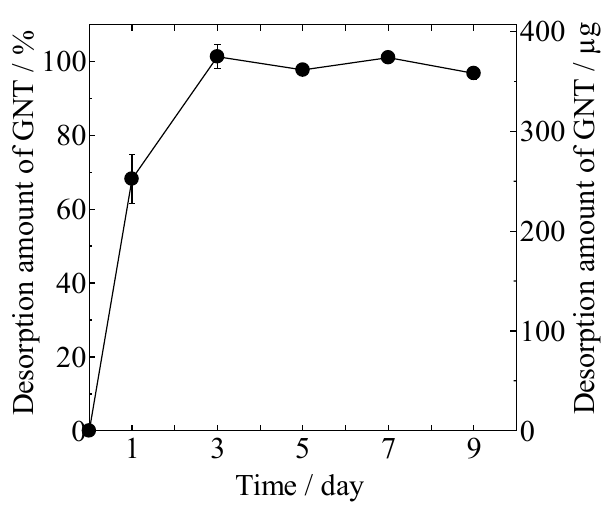
Figure 3. Desorption of GNT from gentamicin sulfate-loaded HAp/Col (GNT-HAp/Col) powder.